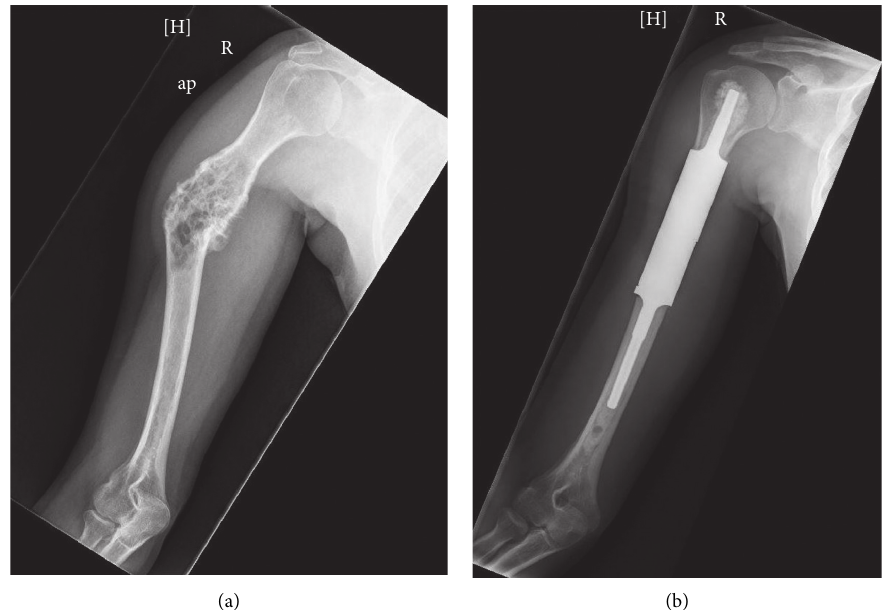
Figure 2: (A) Preoperative radiograph showing lytic lesion in the humerus shaft with deformity. (b) Postoperative radiograph showing well fixed intercalary humerus